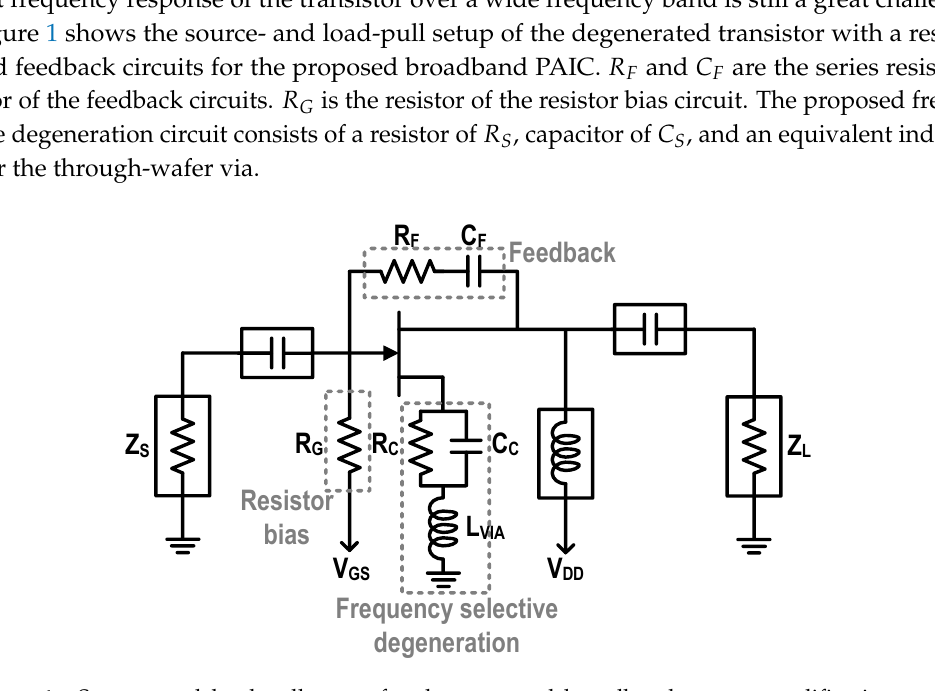
Figure 1. Source- and load-pull setup for the proposed broadband power amplifier integrated circuit